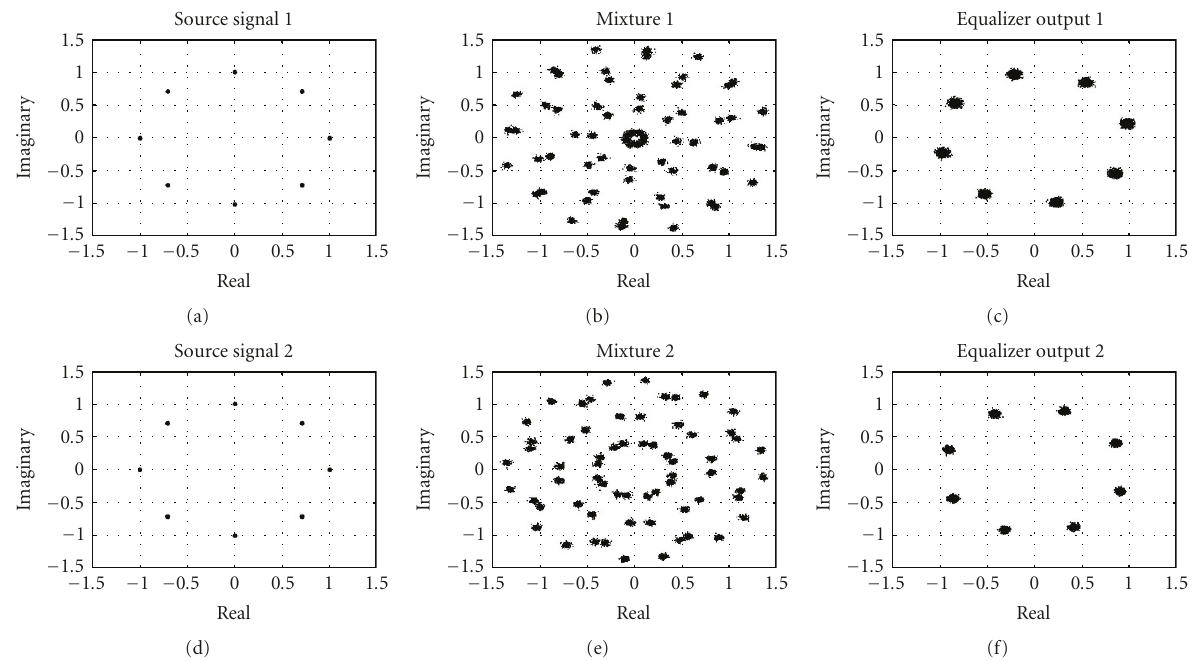
Figure 2: 8-PSK constellation. Left column: the constellations of the transmitted signals, middle column: the constellations of the received signals (mixtures), right column: the constellations of the recovered